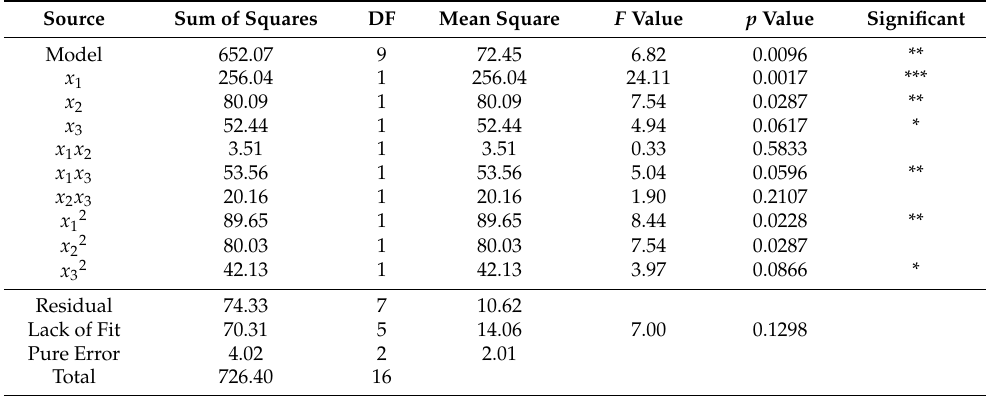
Table 5. Variance analysis of regression equation for forward